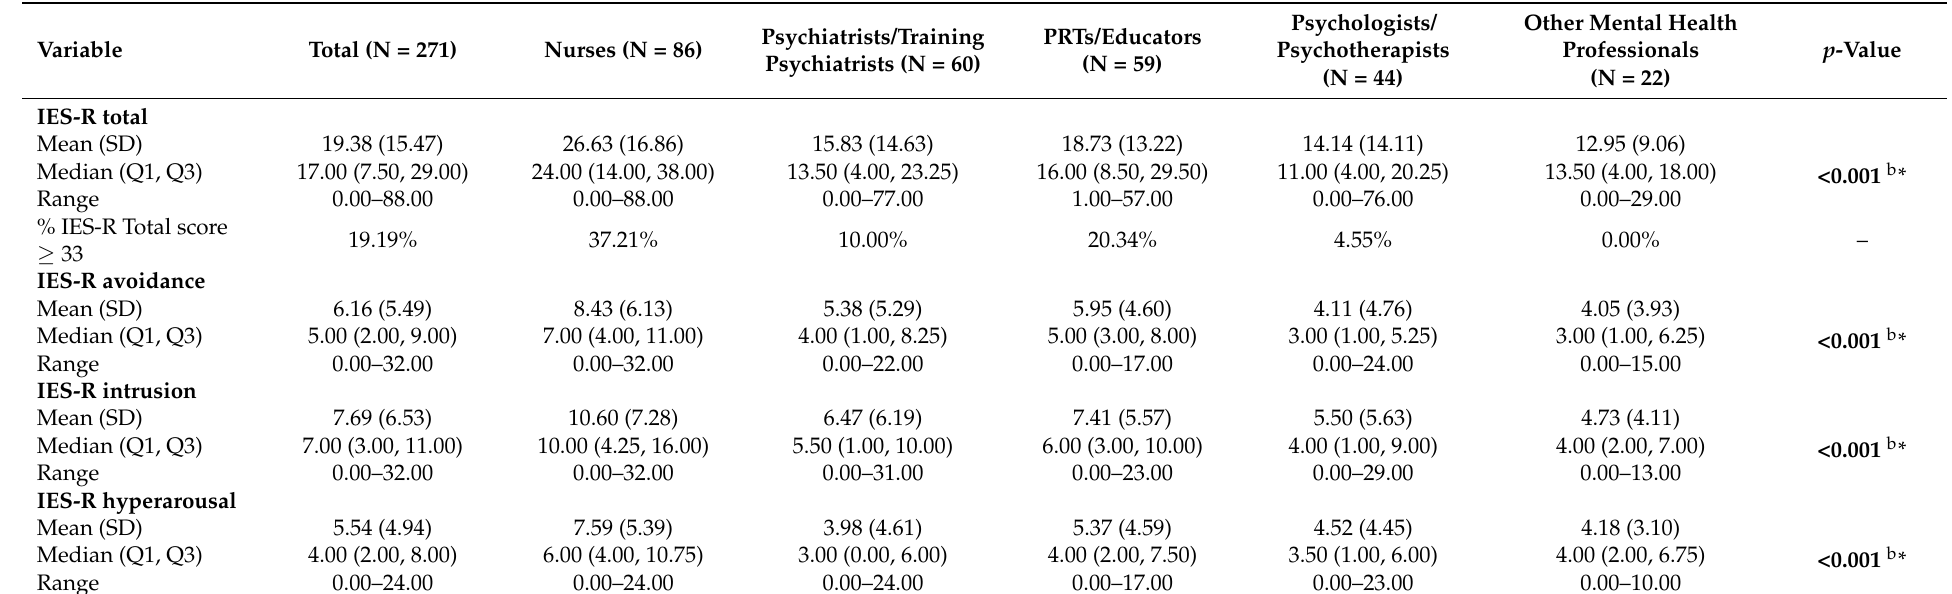
Table 3. Descriptive statistics on IES-R and its subscales stratified by type of professional